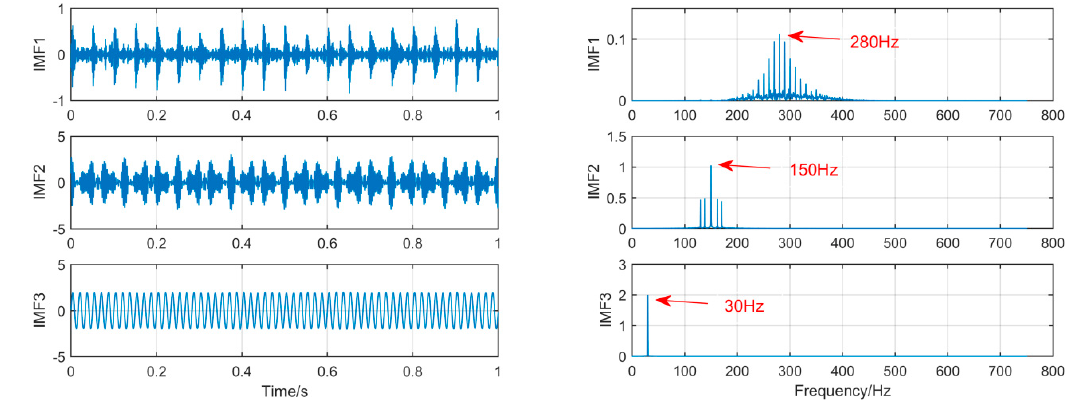
Figure 8. The spectrum of IMFs after SSD and its corresponding spectrum.